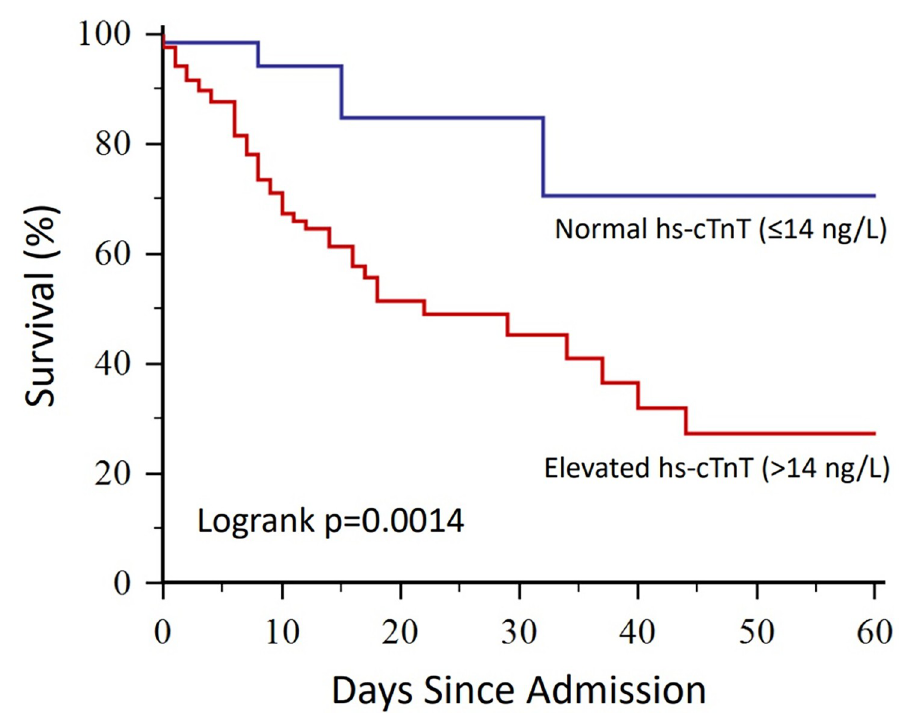
Fig 1. Kaplan Meier curves showing inpatient survival in coronavirus disease 19 (COVID-19) patients with normal versus elevated high sensitivity cardiac troponin T (hs-cTnT).